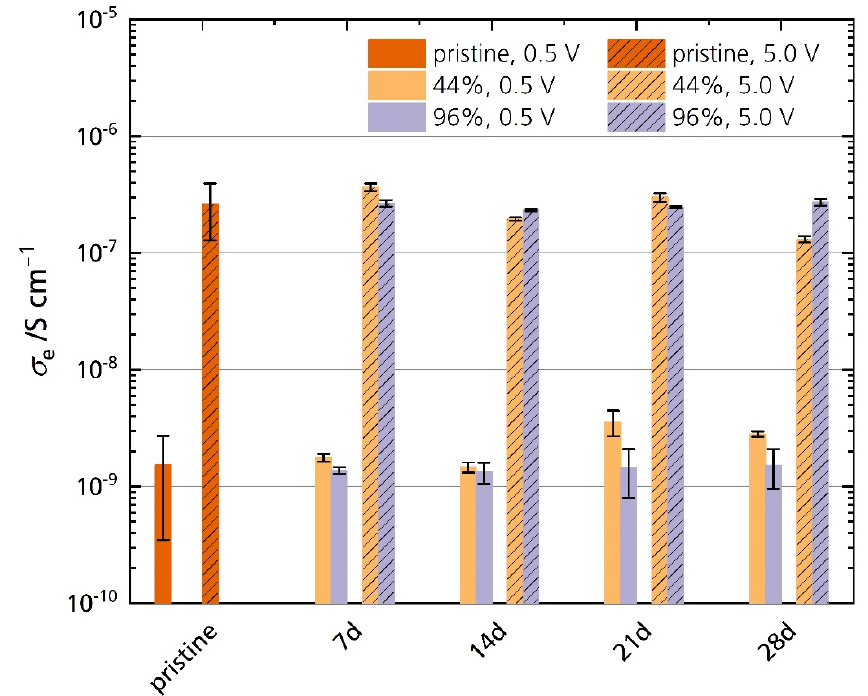
Figure 13. Electronic conductivities of the pristine sample and the samples stored in 44% r.h. and 96% r.h. for 0.5 V and 5.0 V polarization. The error bars represent standard deviations.